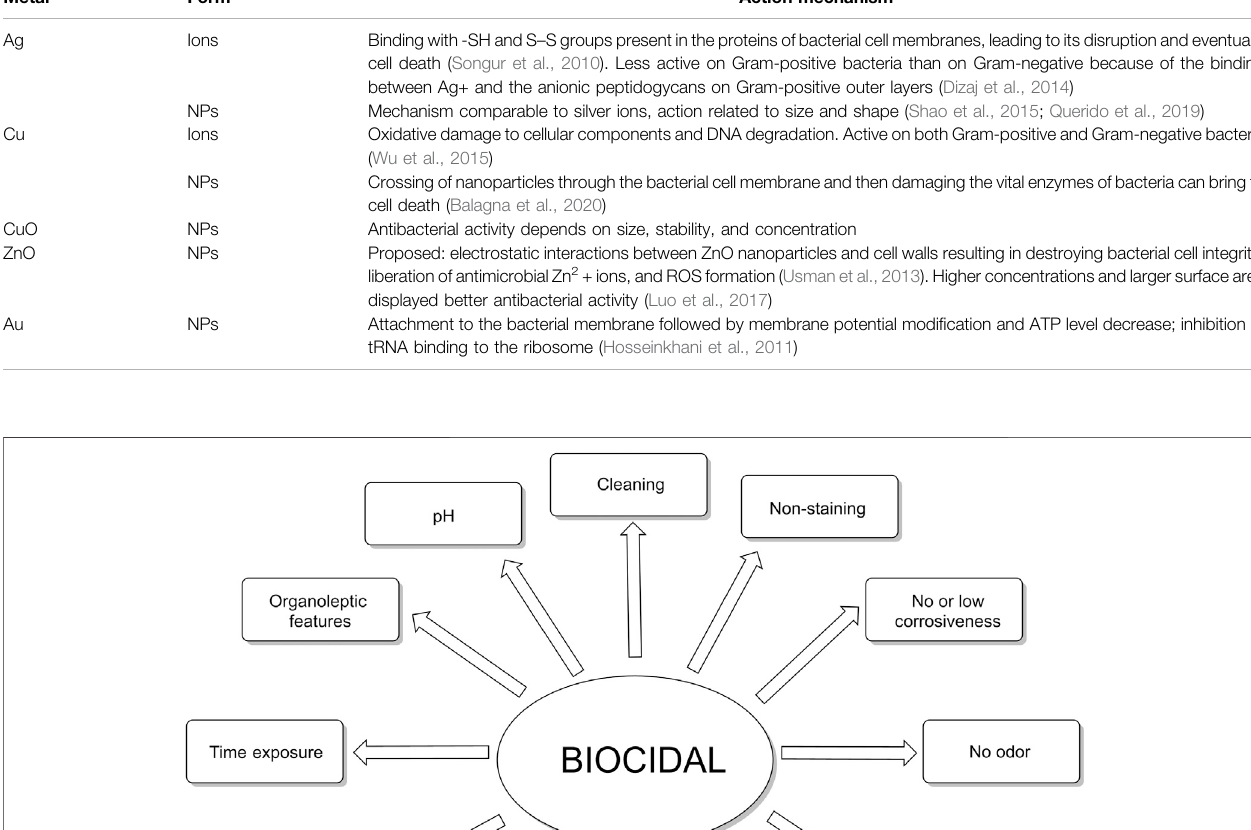
TABLE 2 | Antimicrobial metal and their action mechanism. Metal